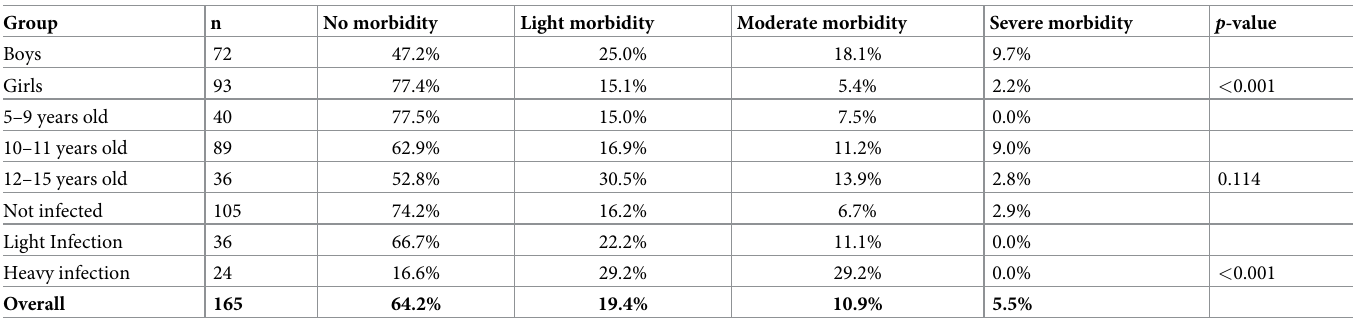
Haematuria Overall, the prevalence of haematuria among the children was 14.8% (n = 245). Among the boys, 23 (21.9%) had haematuria whereas 13 (9.4%) of the girls had haematuria. Girls had lower odds of having haematuria than boys (OR = 0.37, 95% CI: 0.18–0.77). This was statisti- cally significant ( p < 0.008). Age was significantly associated with prevalence of haematuria among the children where 6 (7.1%), 18 (15.0%) and 12 (30.1%) of those in age groups 5–9 years, 10–11 years and 12–15 years, respectively, had haematuria (X 2 = 11.9610; p = 0.003). In relation to infection intensity, 21 (60.0%) of children with heavy S . haematobium infection had haematuria whereas 7 (13.0%) of those with light infection and 8 (5.2%) of those with no infec- tion had haematuria. This was statistically significant (X 2 = 68.4476; p < 0.001). The sensitivity and specificity of IL-6 and IL-10 ELISA and haematuria using urine microscopy as the refer- ence are shown in Table 2. The performances of IL-6, IL-10 and haematuria were also plotted Table 1. Urinary tract morbidity in relation to sex, age and S . haematobium infection intensity.